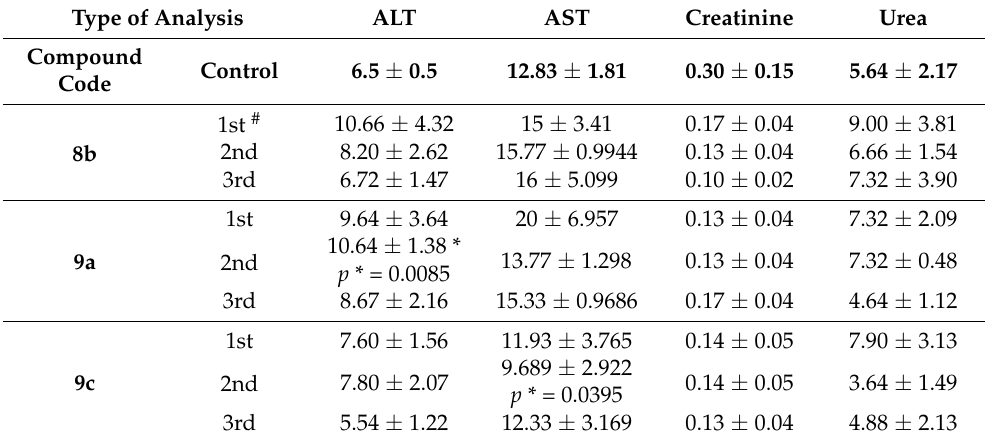
Figure 8. Inhibition effect of three promising synthetic compounds ( 9c , 8b , and 9a ) on the propaga- tion of the H5N1 wild , H5N1 V116A , H5N1 N295S , and H1N1 viruses by HA titration with MOI 0.005 after 72 h. Table 2. Liver and kidney function of mice after receiving the synthetic